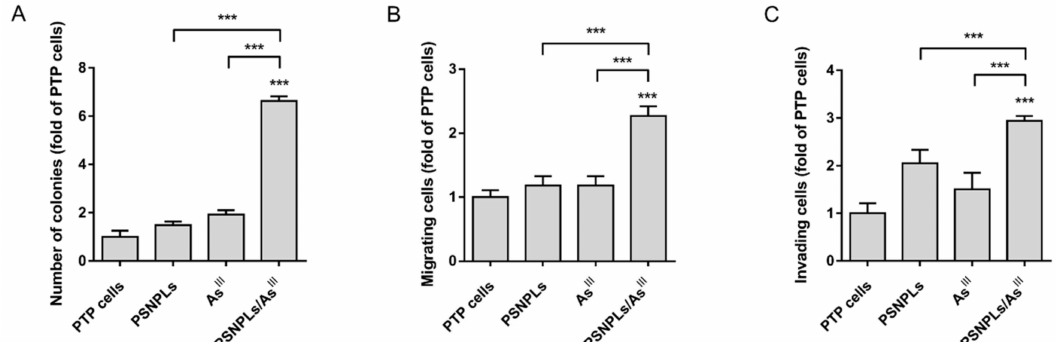
Figure 6. Determination of the in vitro transformed phenotype after the chronic (co)exposure. ( A ) Quantitative data was derived from the number of colonies formed in the anchorage-independent growth assay. ( B ) The proportion of cells able to translocate to the basolateral side of the transwell in the migration, and ( C ) invasion assays. Data are represented as fold of the mean comparing exposed PTP cells with the passage-matched PTP cells. Error bars represent SEM. *** p < 0.001 when compared to all conditions tested by the one-way ANOVA with Dunnett’s post-test.